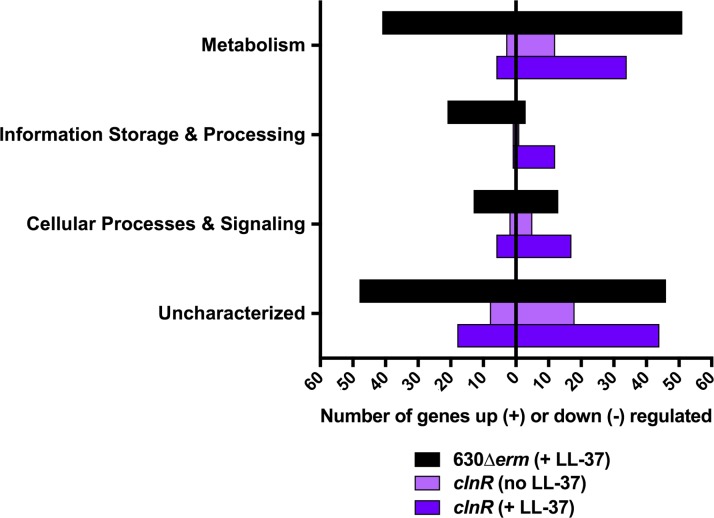
LL-37 and ClnR impact global gene expression.The genes listed in S1 Table (black) and S4 Table (light and dark purple) were assigned COG classifications according to the 2014 COG database. COG classifications were then grouped according to broader functions of Metabolism (COG classes C, E, F, G, H, I, P, and Q), Information Storage & Processing (COG classes A, B, J, K, and L), Cellular Processes & Signaling (COG classes D, M, N, O, T, U, V, W, Y, and Z), and Uncharacterized (COG classes R and S, or unassigned). Genes with functions that fall within two different groups are represented within both of the groups.